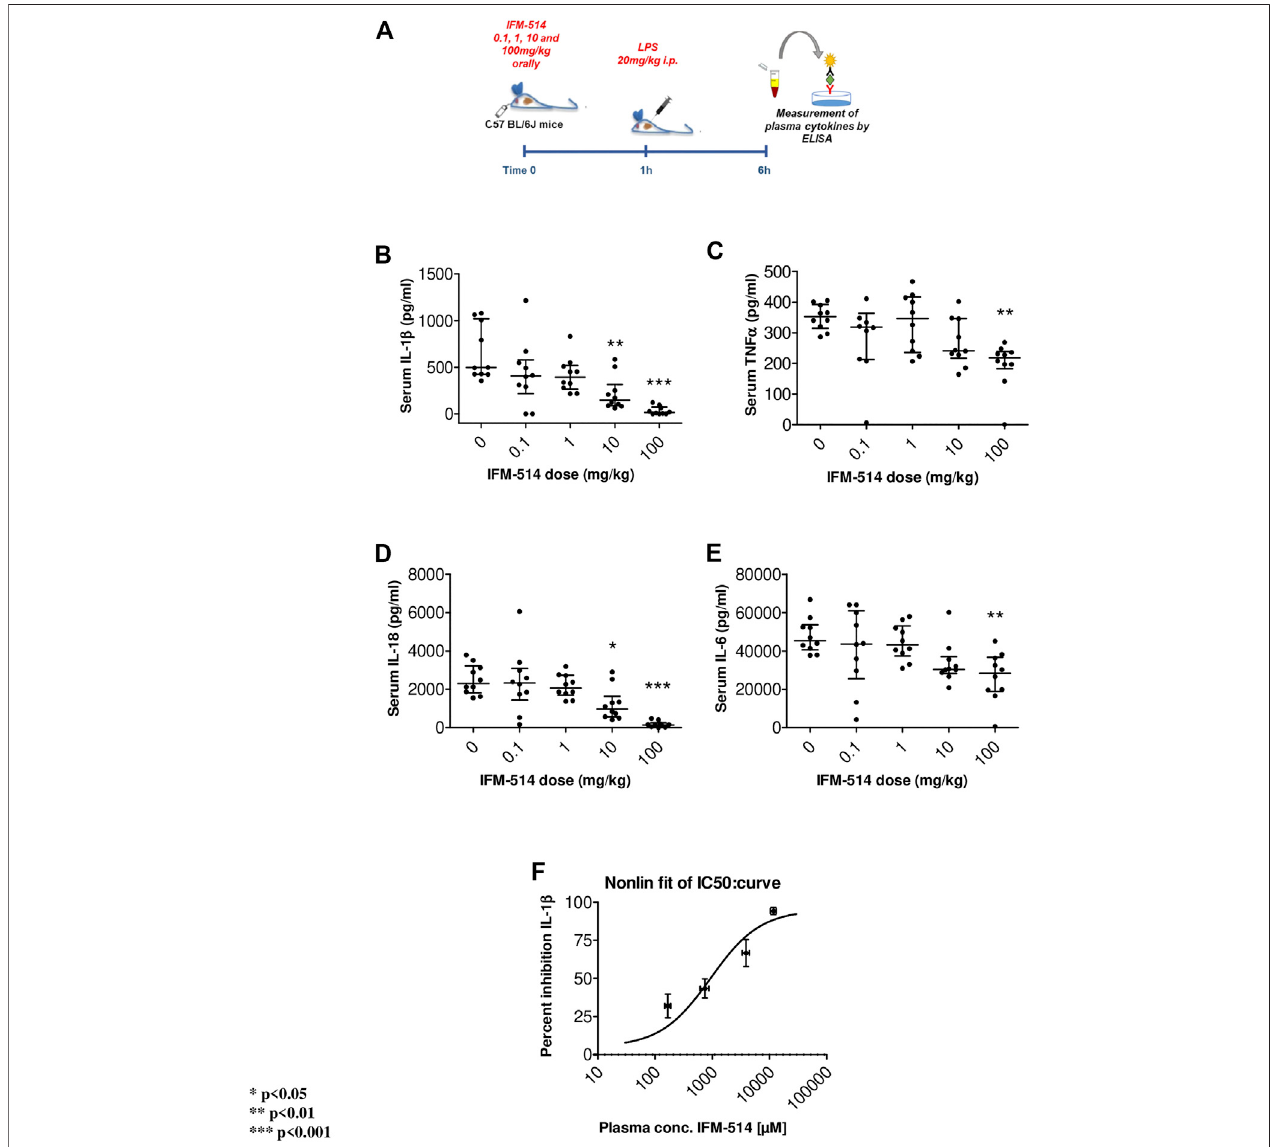
FIGURE1 | Experimentaldesignformouse invivo pharmacodynamicsmodel:LPSstimulationofplasmacytokines.IFM-514wasdosedorallyinWTC57BL/6miceat 0.1,1,10and100 mg/kg1 hbeforeLPS(20 mg/kgi.p.) (A) .LPS-inducedproductionofplasmacytokinesIL-1 β (B) ,TNF α (C), IL-18 (D) andIL-6 (E) measuredbyELISA5 h after LPS challenge. IFM-514 signi fi cantly inhibited IL-1 β production in vivo when dosed orally with an IC50 (cid:1) 947 ng/ml; 95% CI 499.5 – 1,683 ng/ml (F). Results are expressed as mean ± standard error of the mean (SEM); n (cid:1) 10/group, * p < 0.05, ** p < 0.01 and *** p < 0.001. Abbreviations: ELISA, enzyme-linked immunosorbent assay; IC50, half maximal inhibitory concentration; IL1 β , interleukin 1 β ; IL-16, interleukin 16; IL18, interleukin 18; LPS, lipopolysaccharide; TNF α , tumor necrosis factor α .